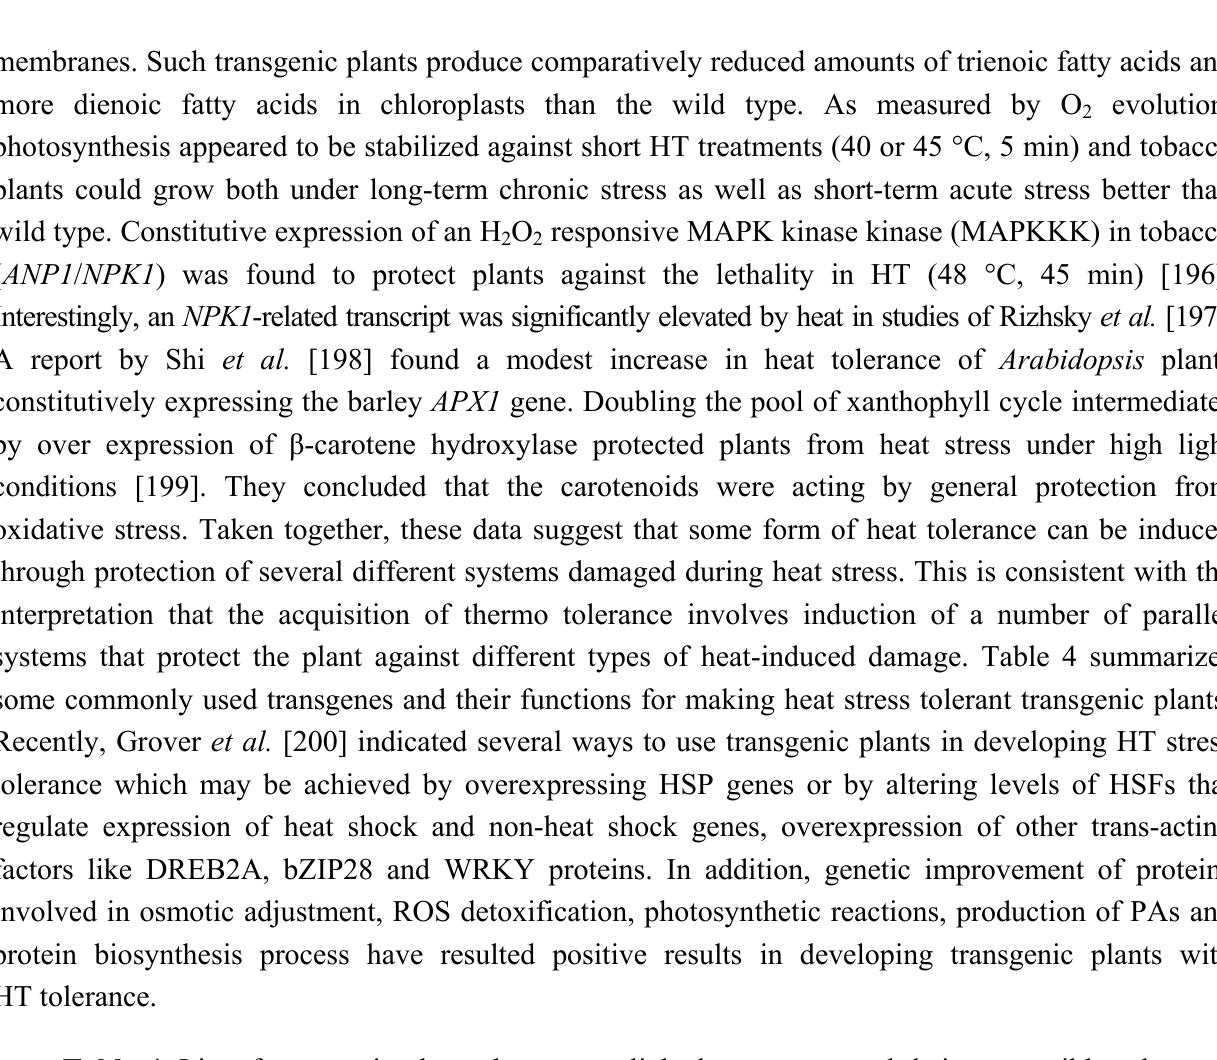
Table 4. List of transgenic plants, heat stress linked transgenes and their responsible role for enhancing plants towards stress